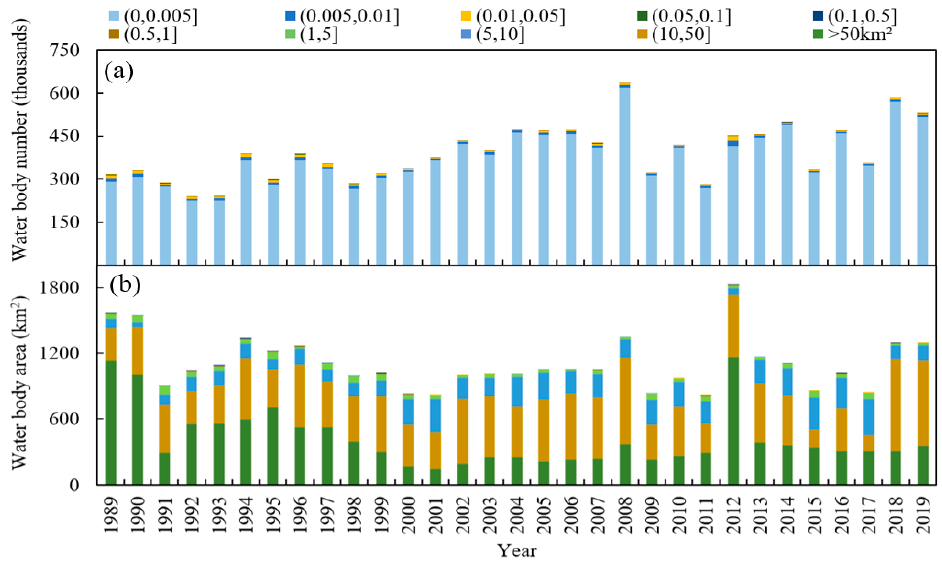
Figure 8. Distribution of the number ( a ) and area ( b ) of the maximum water bodies at different spatial scales from 1989 to 2019.